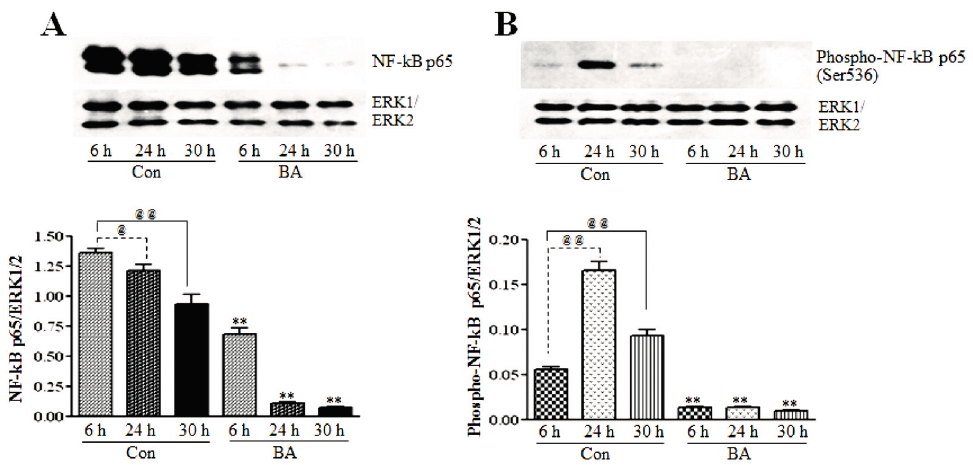
Figure 6. The effect of butyrate on NF- κ Bp65 protein expression and transcriptional activation. VSMC were treated with 5 mM butyrate for the required periods of time. At the end of the treatment, cell lysates were prepared and processed for assessing total NF- κ Bp65 and NF- κ Bp65 phosphorylated at serine536 by western blotting ( top ). Band intensities are normalized to ERK1/ERK2 and presented as a bar graph ( bottom ). Respective data are presented as the mean ± SD of at least three independent experiments. ( A ) Total NF- κ B expression is determined by NF- κ Bp65 antibody ( top ). @ p < 0.05 vs. 6 h control, @@ p < 0.001 vs. 6 h control, ** p < 0.001 vs. respective controls. ( B ) The phospho-NF- κ Bp65 level is evaluated by the antibody specific to